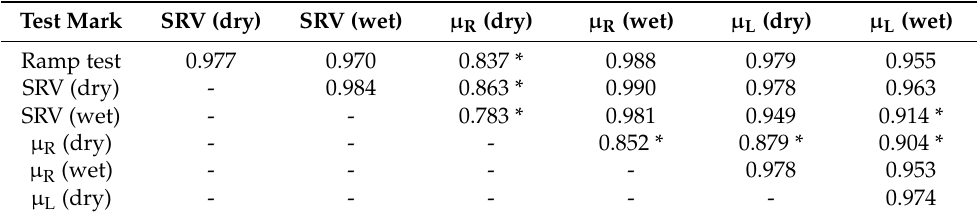
Table 2. Pearson’s correlation coefficient between test methods.